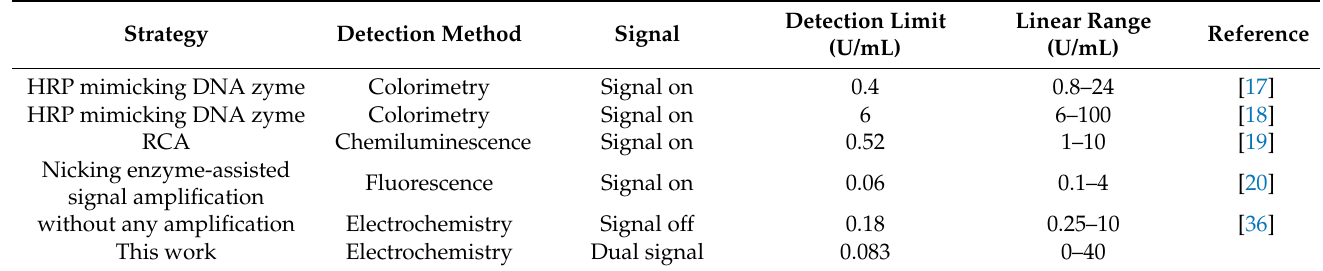
Figure 4. ( A ) SWV curves for the different concentrations of M.SssI MTase. The concentrations are (from a to h) 0 U/mL, 0.25 U/mL, 0.375 U/mL, 0.5 U/mL, 1 U/mL, 10 U/mL, 20 U/mL, and 40 U/mL. Dependence of I MB ( B ) and I Fc ( C ) on M.SssI MTase concentration. Insets in ( B , C ) are the linear relationship between the logarithmic function of I MB and I Fc , respectively. ( D ) Dependence of I Fc /|I MB | on M.SssI MTase concentration. Insets show the linear fit plots of I Fc , or I MB, and I Fc /|I MB | as a function of the M.SssI MTase concentration. Insets are the linear relationship between I Fc /|I MB | and the concentration of M.SssI MTase ranging from 0 to 2 U/mL. Table 1. A comparison of detection performance in the current work with previously reported methods for DNA